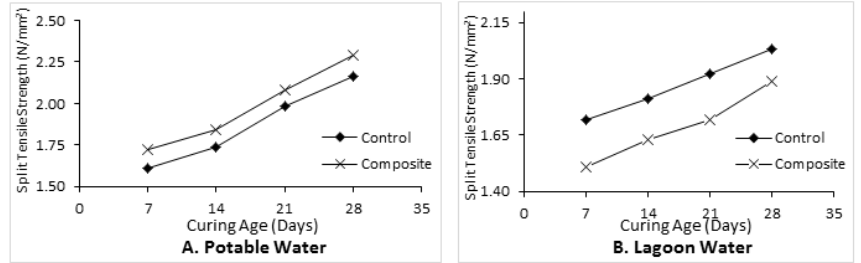
Figure 5. Variation of splitting tensile strength of pozzolan blended steel slag aggregate